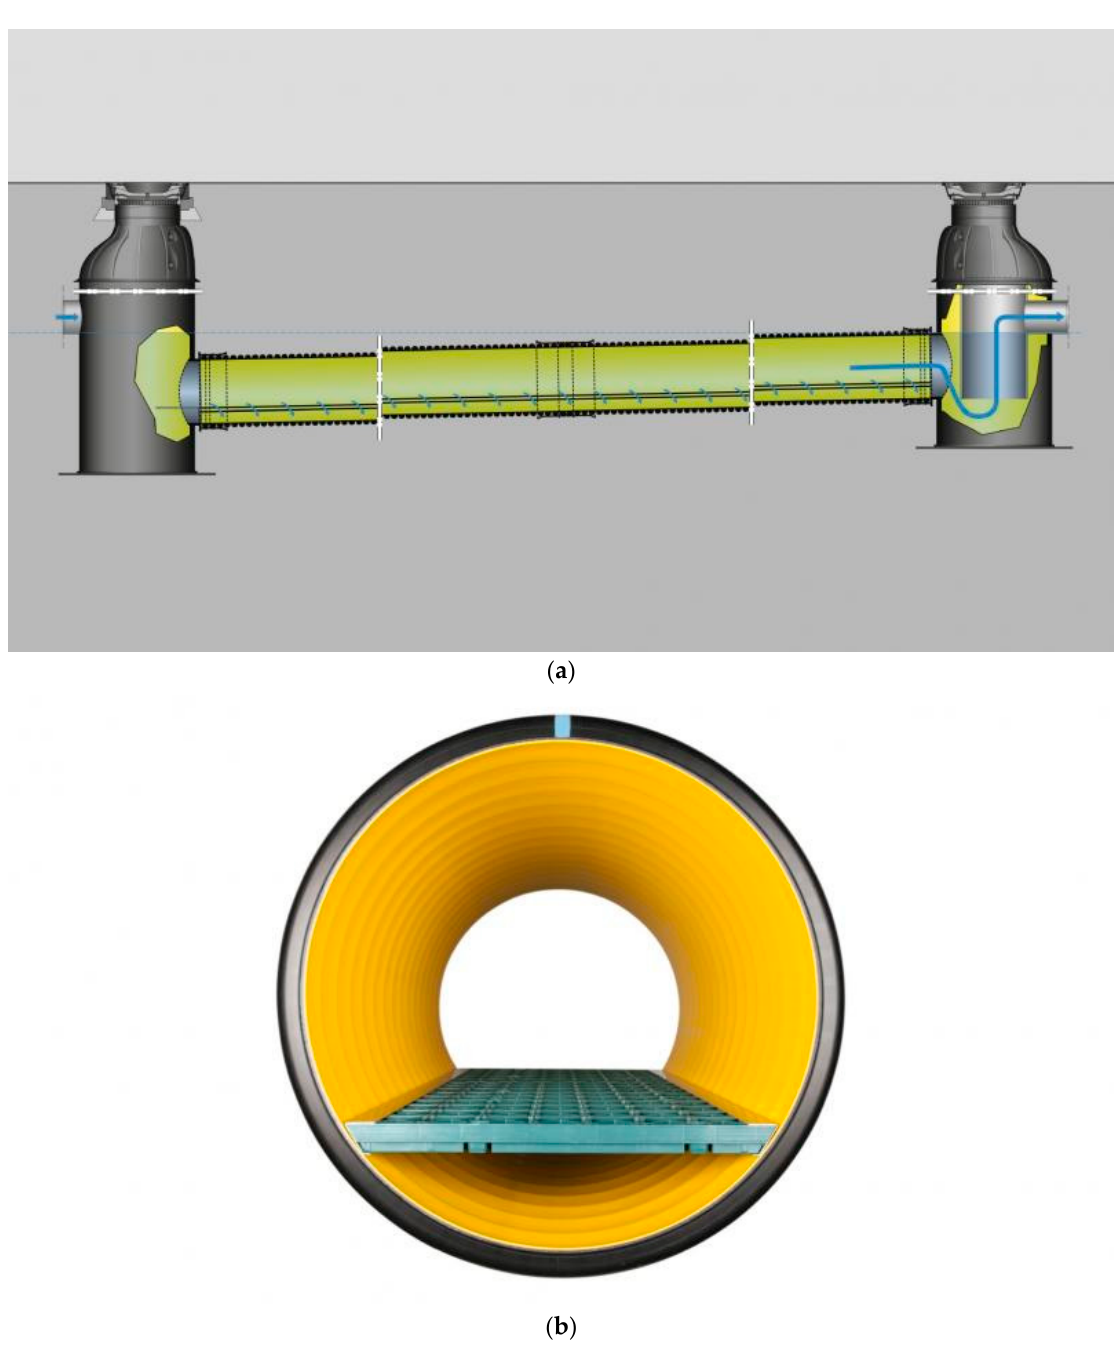
Figure A1. Schematic of the SediPipe XL 600/12 in lateral section ( a ) and in cross section ( b ) [49].